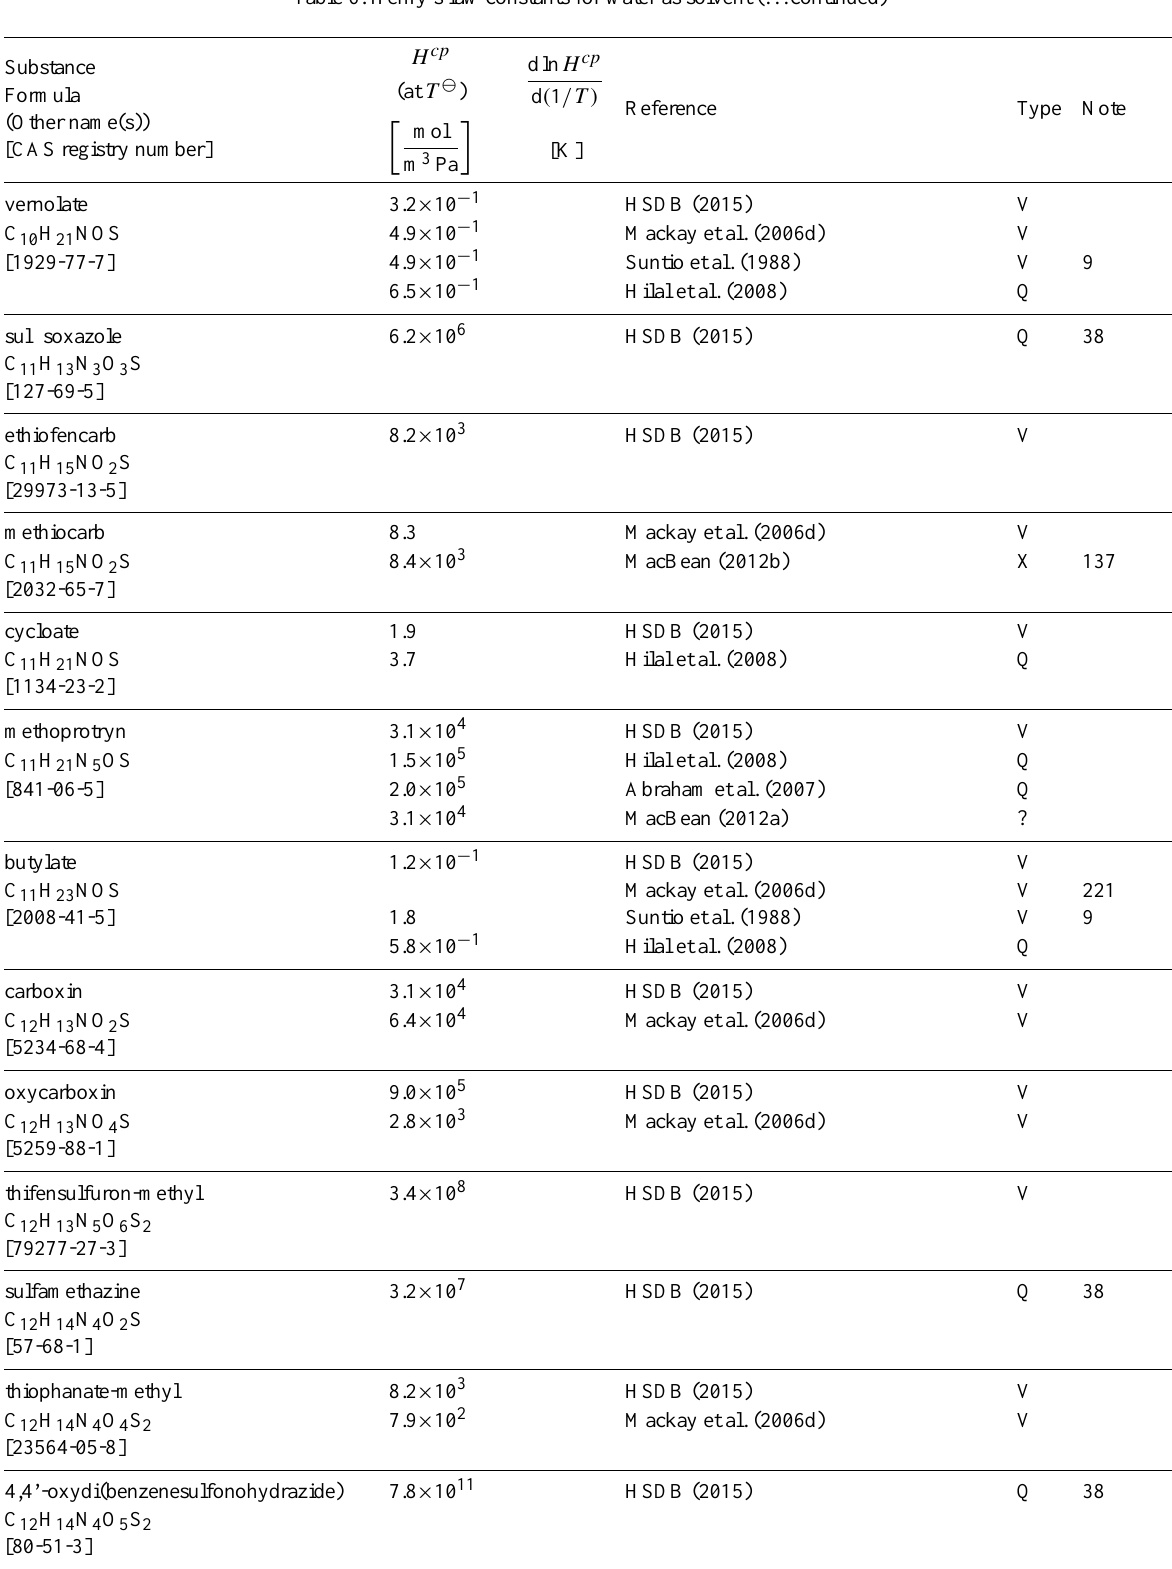
Table 6: Henry’s law constants for water as solvent